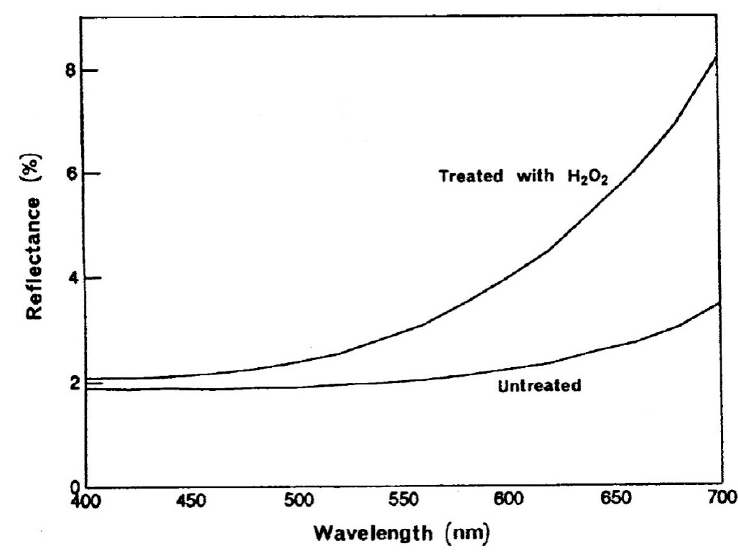
Figure 10. Reflectance spectra of hair, adapted from Wolfram et al. [4], with permission from Society of Cosmetic Chemists, 1987.